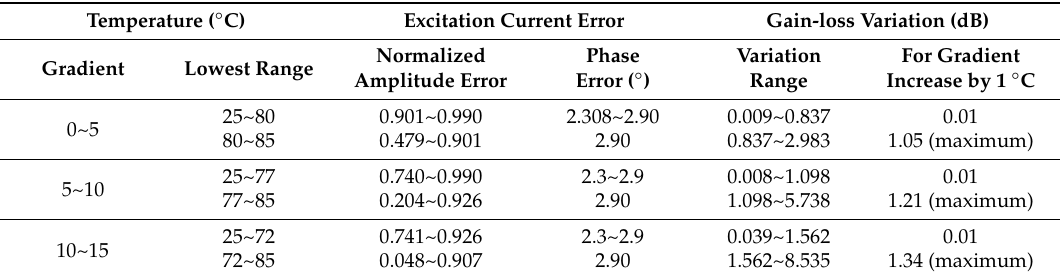
Table 2. Gain-loss under the effect of symmetric temperature distribution.